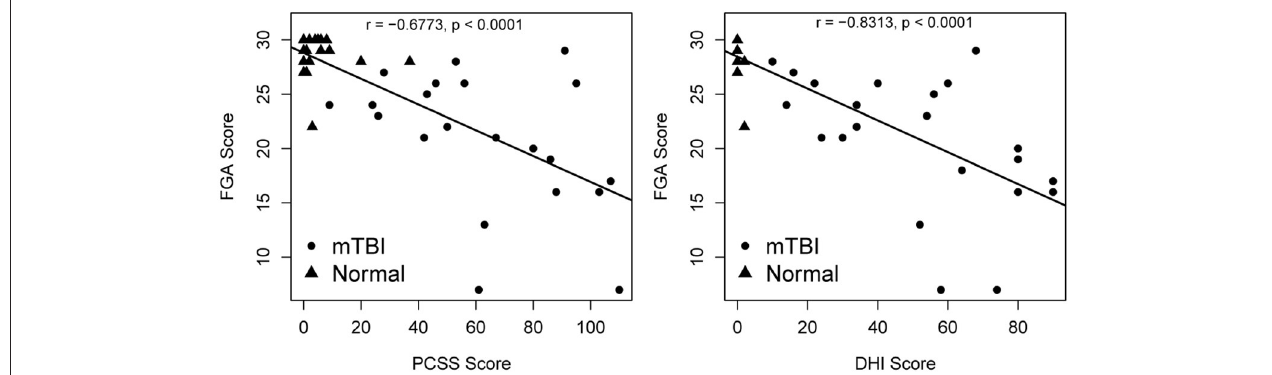
FIGURE 4 | Relationship between DHI, PCSS, and FGA score. p -values are significant at α = 0.004 after Bonferroni adjustment. DHI, Dizziness Handicap Inventory; PCSS, Post-concussion Symptom Scale; FGA, Functional Gait